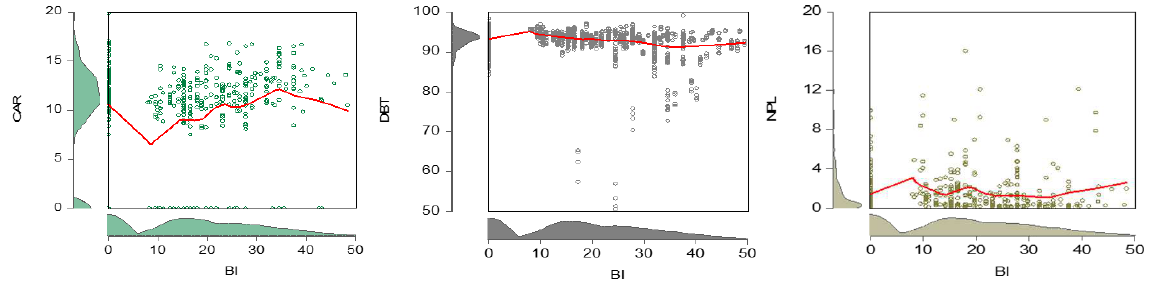
Figure 1. The nearest neighbor fit of BI vs. CAR, BI vs. NPL, and BI vs.